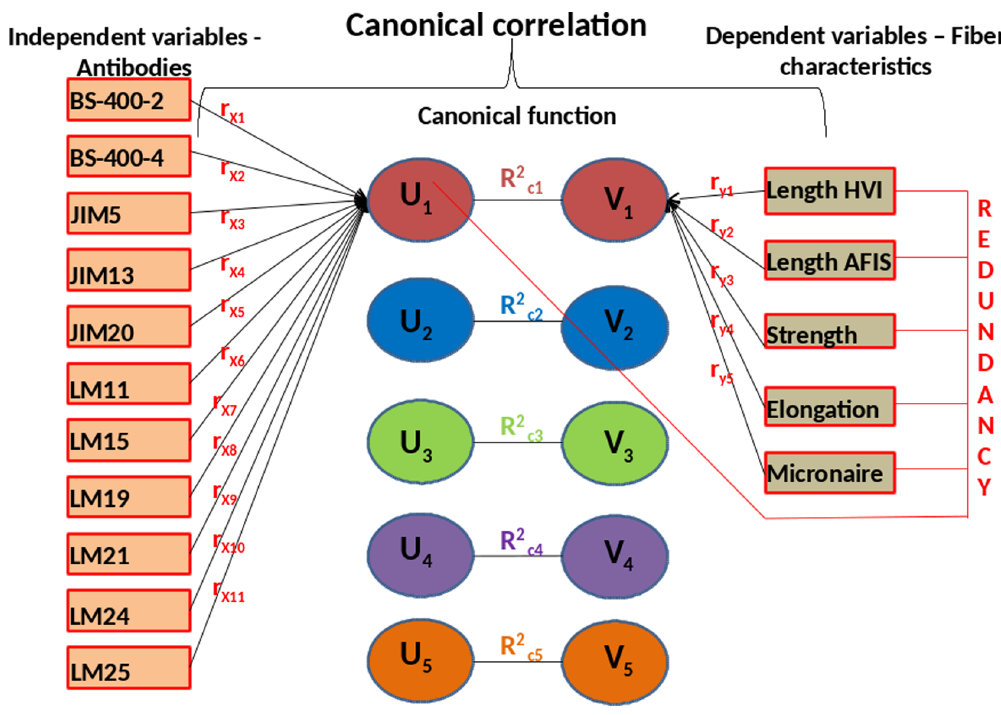
Figure 1. Canonical correlation analysis maximizes the correlation between the linear combination of the cell wall polysaccharides in the glycan array and the fiber properties. In this figure, given a linear combination of X variables: U 1 = f 1 6 1 + f 2 6 2 + … + f p X p and a linear combination of Y variables: V 1 = g 1 Y 1 + g 2 Y 2 + … + g q Y q , the first canonical correlation is the maximum correlation coefficient between U 1 and V 1 , for all U 1 and V 1 .